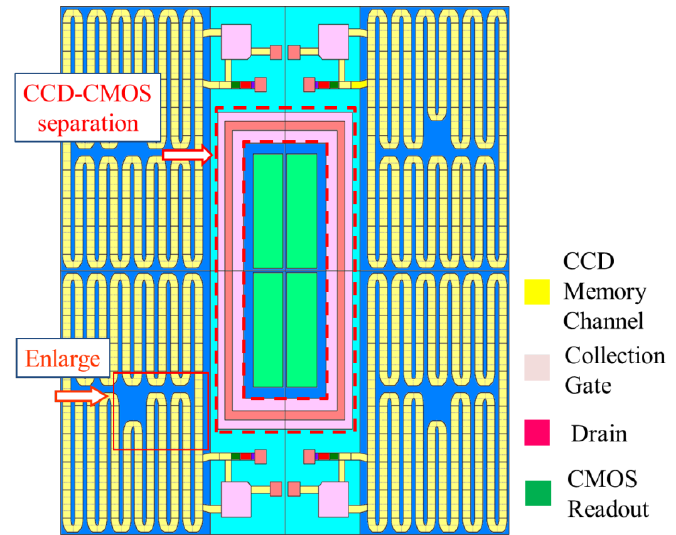
Figure 5. Layout of 2 × 2 pixels in ISAS with folded and looped storage CCDs [14].